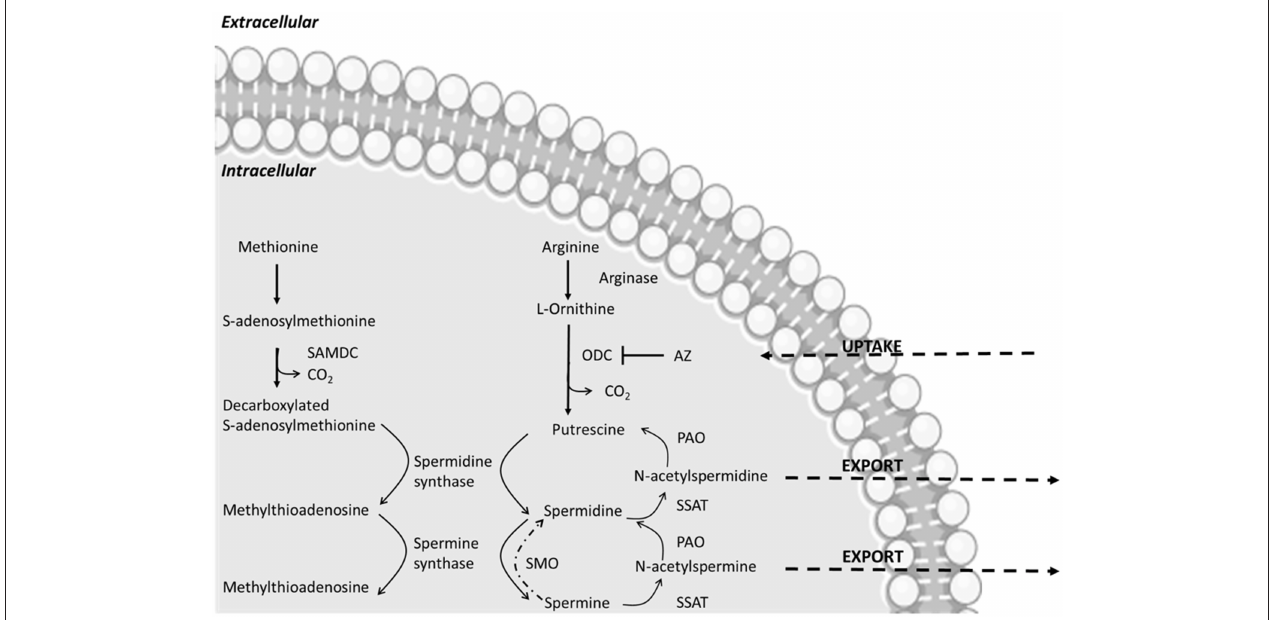
FIGURE 1 | Main polyamine metabolic pathways modified from Linsalata et al. (27). The abbreviations used are as follows: ODC, ornithine decarboxylase; SAMDC, S-adenosylmethionine decarboxylase; SSAT, spermidine-spermine-N-acetyl transferase; PAO, polyamine oxidase; AZ, antizyme; SMO, spermine oxidase. AZ inactivates ODC, increases polyamine efflux and decreases polyamine